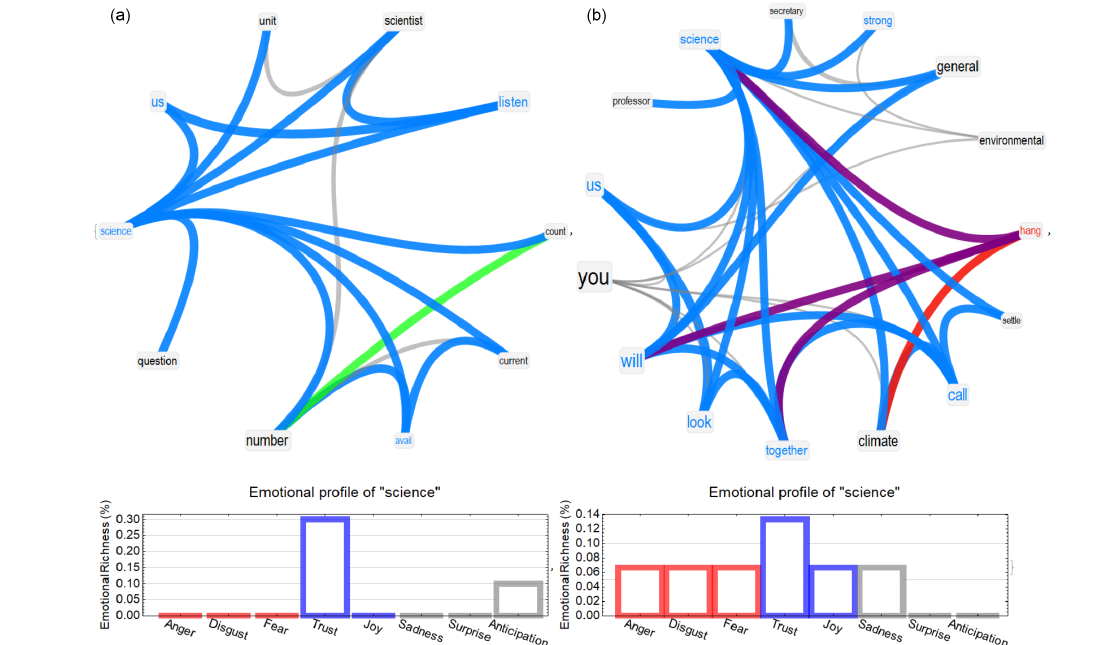
Figure A1. Speakers’ mindset reconstruction around “Science” in the speeches of Greta Thunberg (a) and Christopher Monckton (b) . We refer the reader to Fig. 1 for a detailed explanation of the colour code and to Lexicon 1 for an interpretation of the figure.